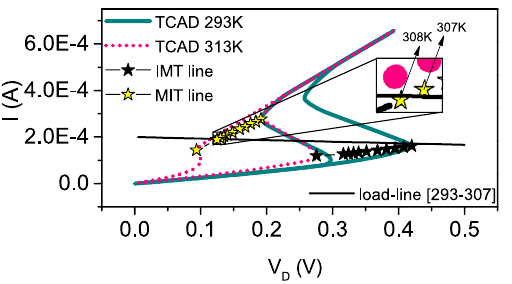
Figure 3. Simulated I – V D at external temperature of T 0 = 293 K (solid dark cyan line) and T 0 = 313 K (pink dotted line). The IMT/MIT points for T 0 ranging from 293 K (the rightmost ones) to 313 K (the leftmost ones) are shown as black (IMT) and yellow (MIT) starred lines, respectively. The black line is the load line valid for the temperature interval [293–307] K. The inset shows the MIT points for T 0 = 307 K (on the right) and T 0 = 308 K (on the left). It is evident that the MIT point for T 0 = 307 K is above the load-line, while the MIT point for T 0 = 308 K is below